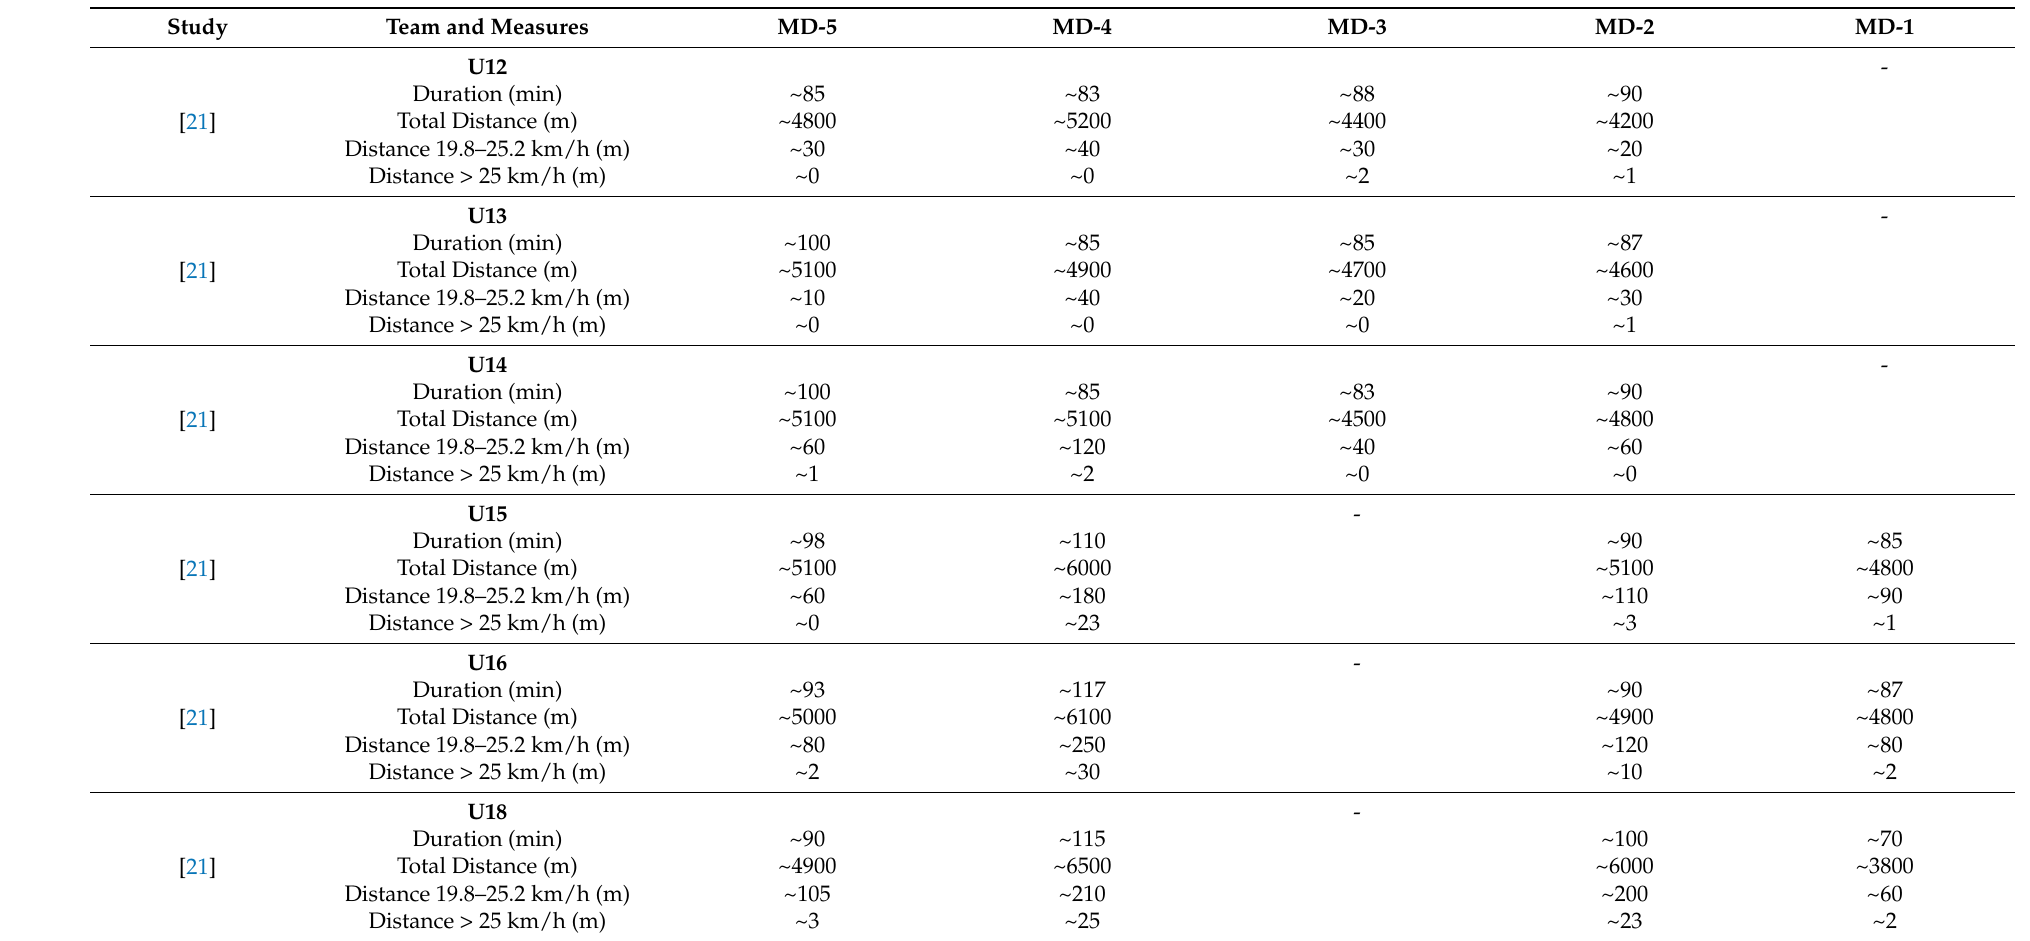
Table 5. Results for external training intensity by match-day minus and by players